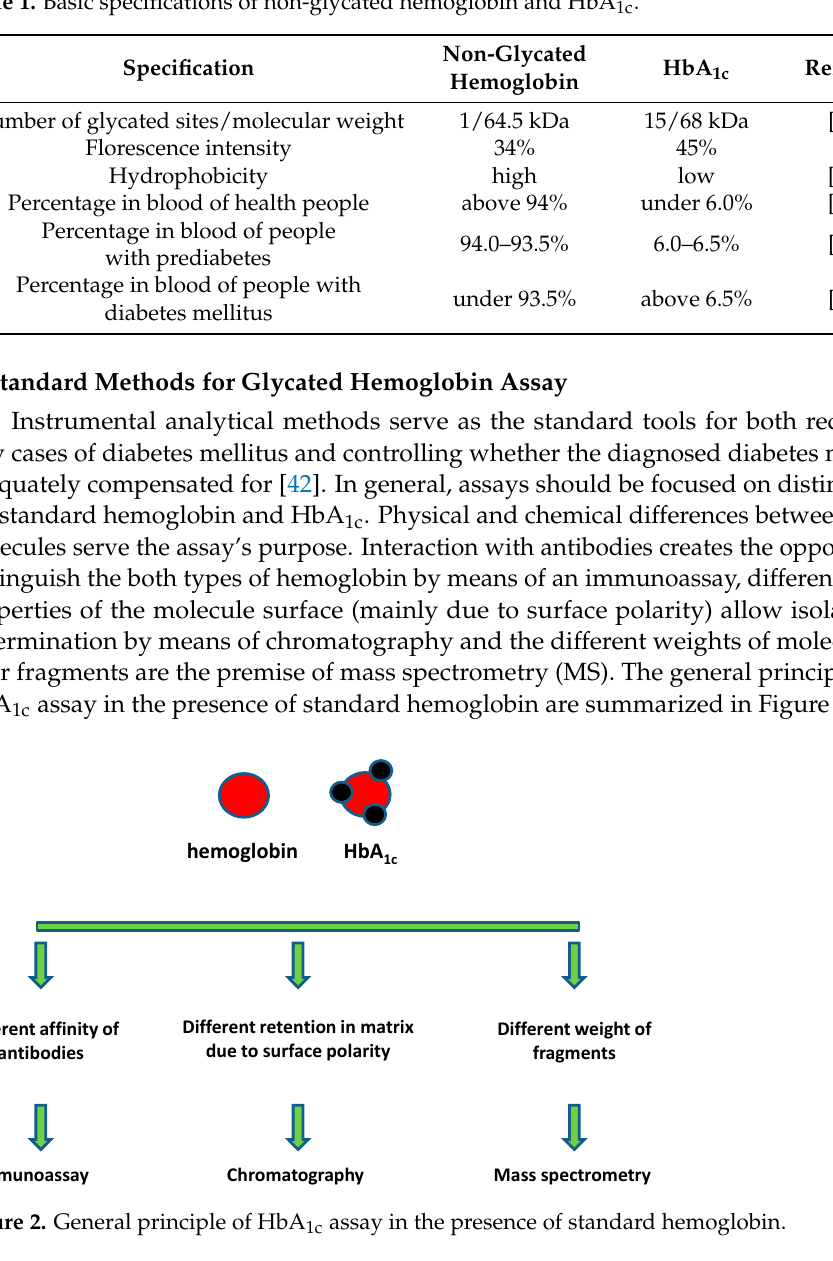
Table 1. Basic specifications of non-glycated hemoglobin and HbA 1c .